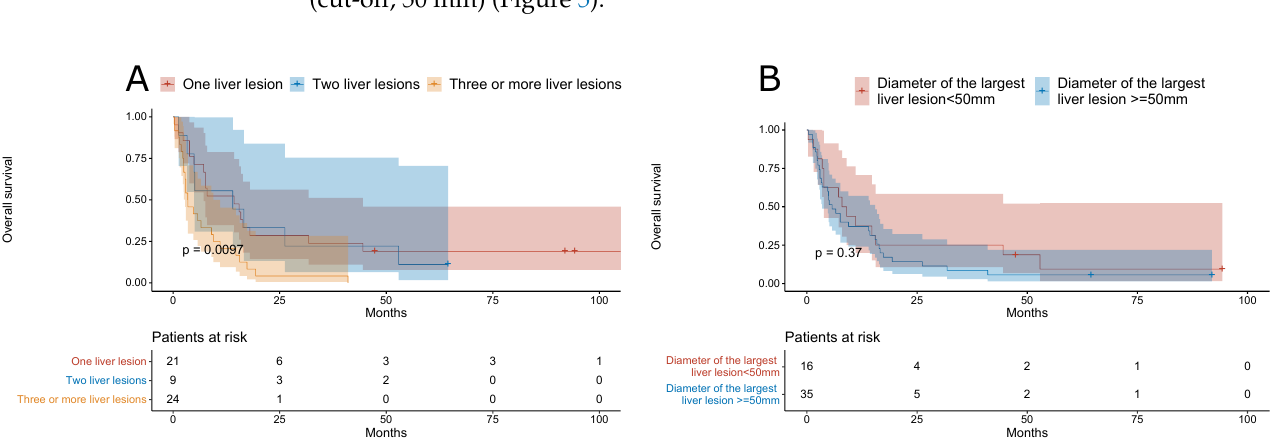
Figure 5. ( A ) Overall survival of NAFLD-related HCC patients stratified by the number of liver lesions. ( B ) Overall survival of NAFLD-related HCC patients stratified by the diameter of the largest lesion (cut-off value, 50